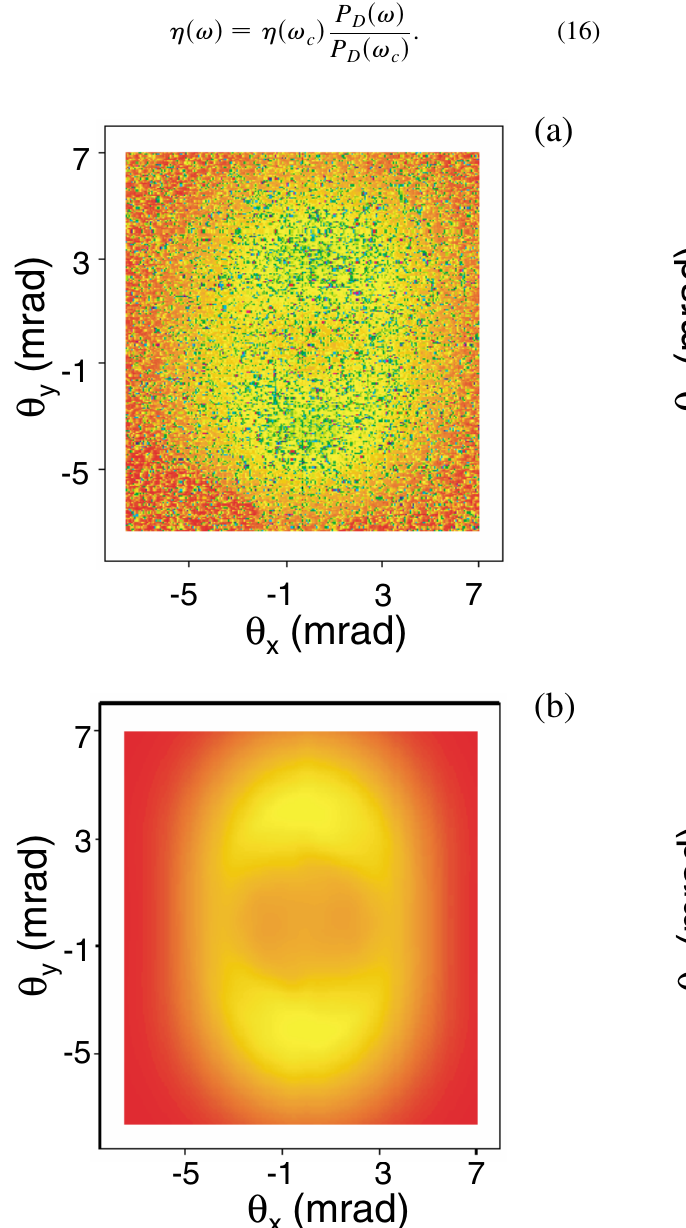
FIG. 10. (Color) Measured (a) and simulated (b) intensity pro- file for x-rays transmitted through a 0.125 mm Ta foil. The measured electron beam energy was 57 MeV, while the energy used in the simulation was 58 MeV.